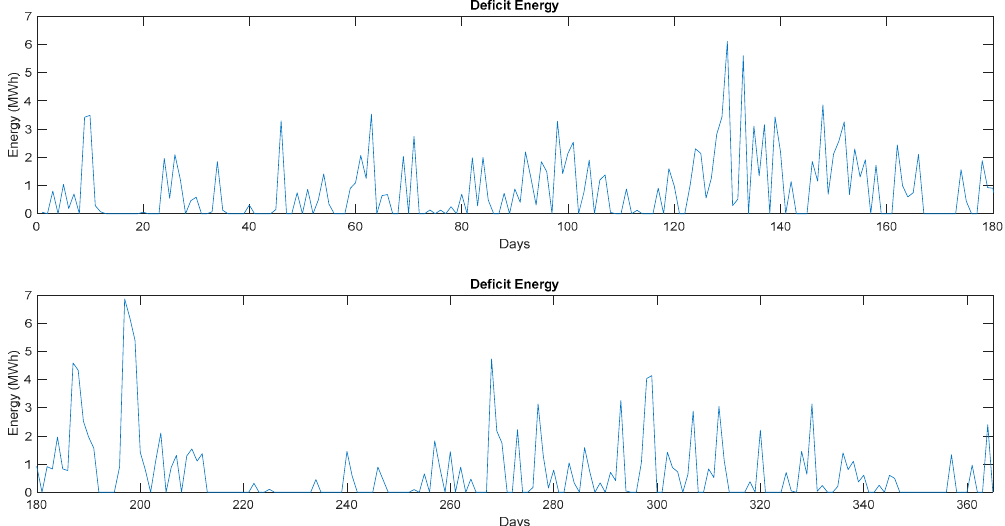
Figure 9. The deficit energy for the proposed design through that particular year .